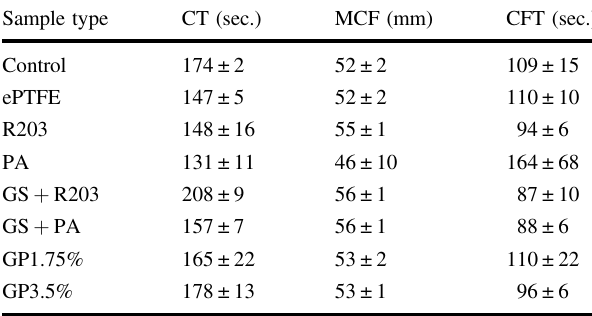
Table 3 Coagulation properties of gentamicin-coated ePTFE grafts and the control groups (human blood, untreated ePTFE graft, and ePTFE grafts coated only with PA respectively